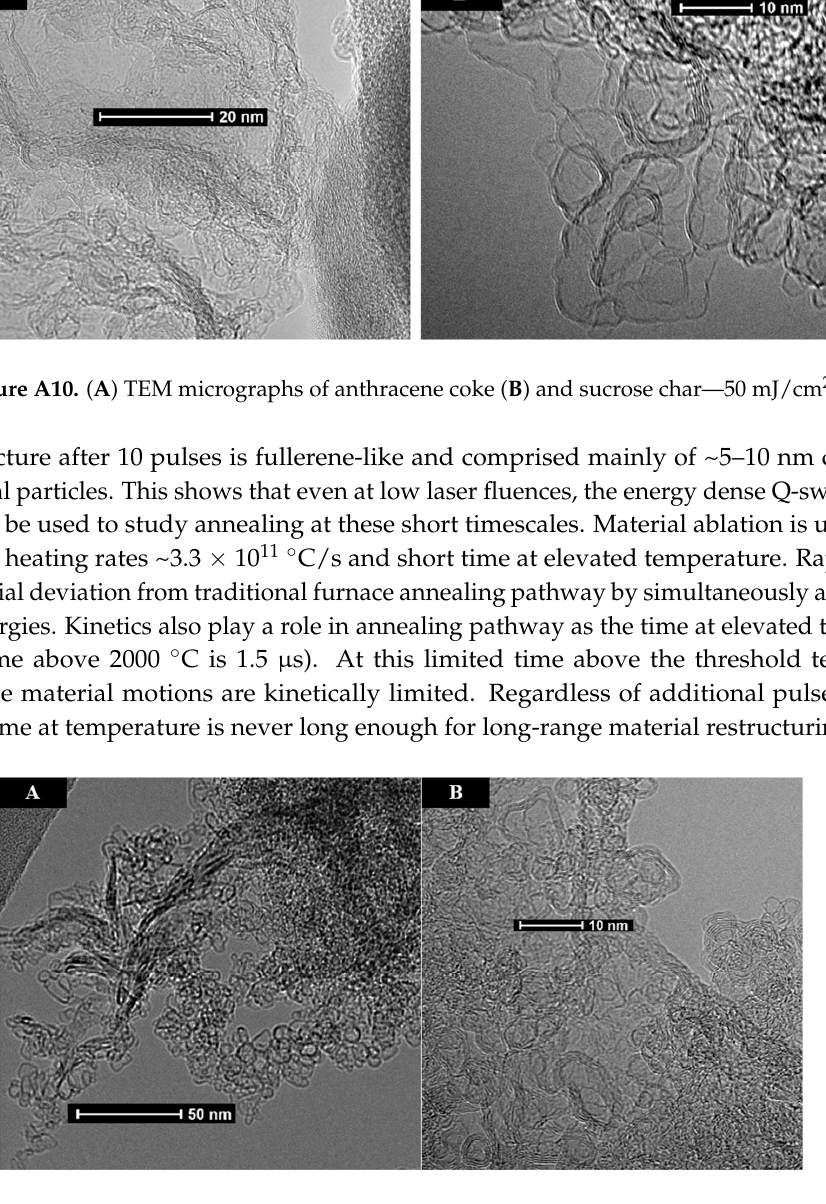
Figure A9. TTHs of sucrose char and anthracene coke—50 mJ/cm 2 .